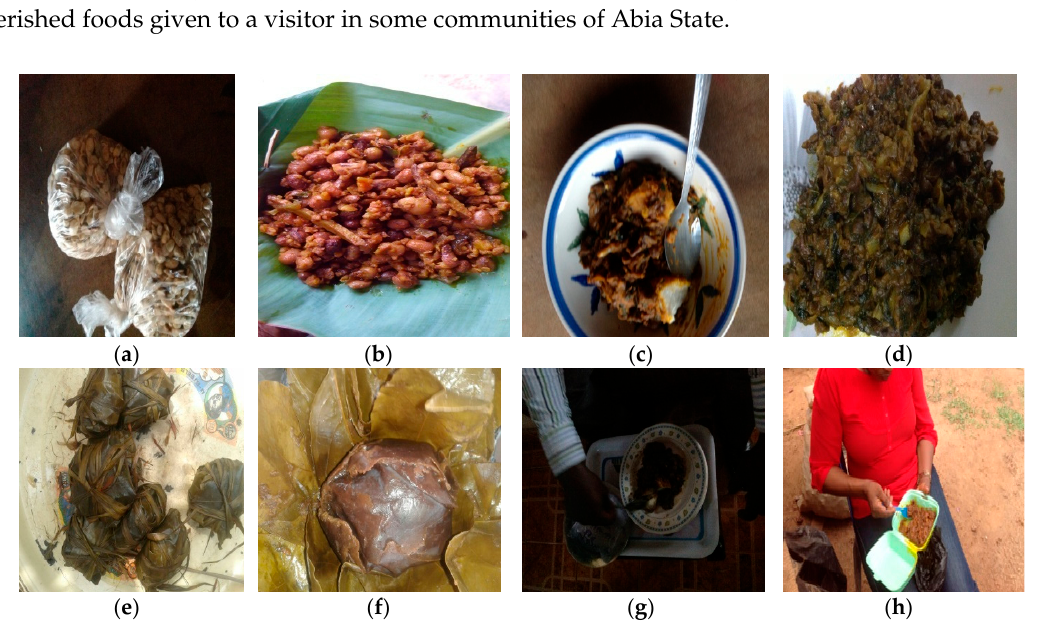
Figure 6. Diversity of foods prepared from Sphenostylis stenocarpa accessions in the five states of southeast Nigeria. ( a – h ): AYB in association with other crops eaten in southeast Nigeria. ( a )